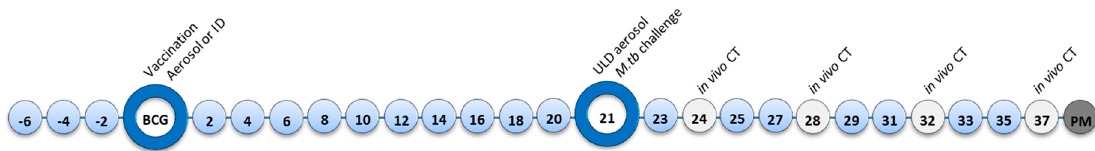
Figure 1. Study timeline relative to aerosol or ID BCG vaccination. Rhesus macaques received BCG vaccination delivered by aerosol ( n = 6) or intradermal injection ( n = 6) at study week zero or were left as unvaccinated controls ( n = 7). All animals received ultra-low dose (ULD) aerosol challenge with M. tuberculosis Erdman strain (ERD ≤ 10 CFU) at study week 21 and were monitored for up to 16 weeks following infection (study week 37). Blue shaded circles represent procedures involving blood sample collection and application of immunological analyses, large open circles represent key study events: vaccination and ULD aerosol M. tuberculosis challenge, open circles indicate application of in vivo CT scanning. All animals were euthanized, and post-mortem (PM) necropsies conducted upon completion of the study schedule (shaded circles).